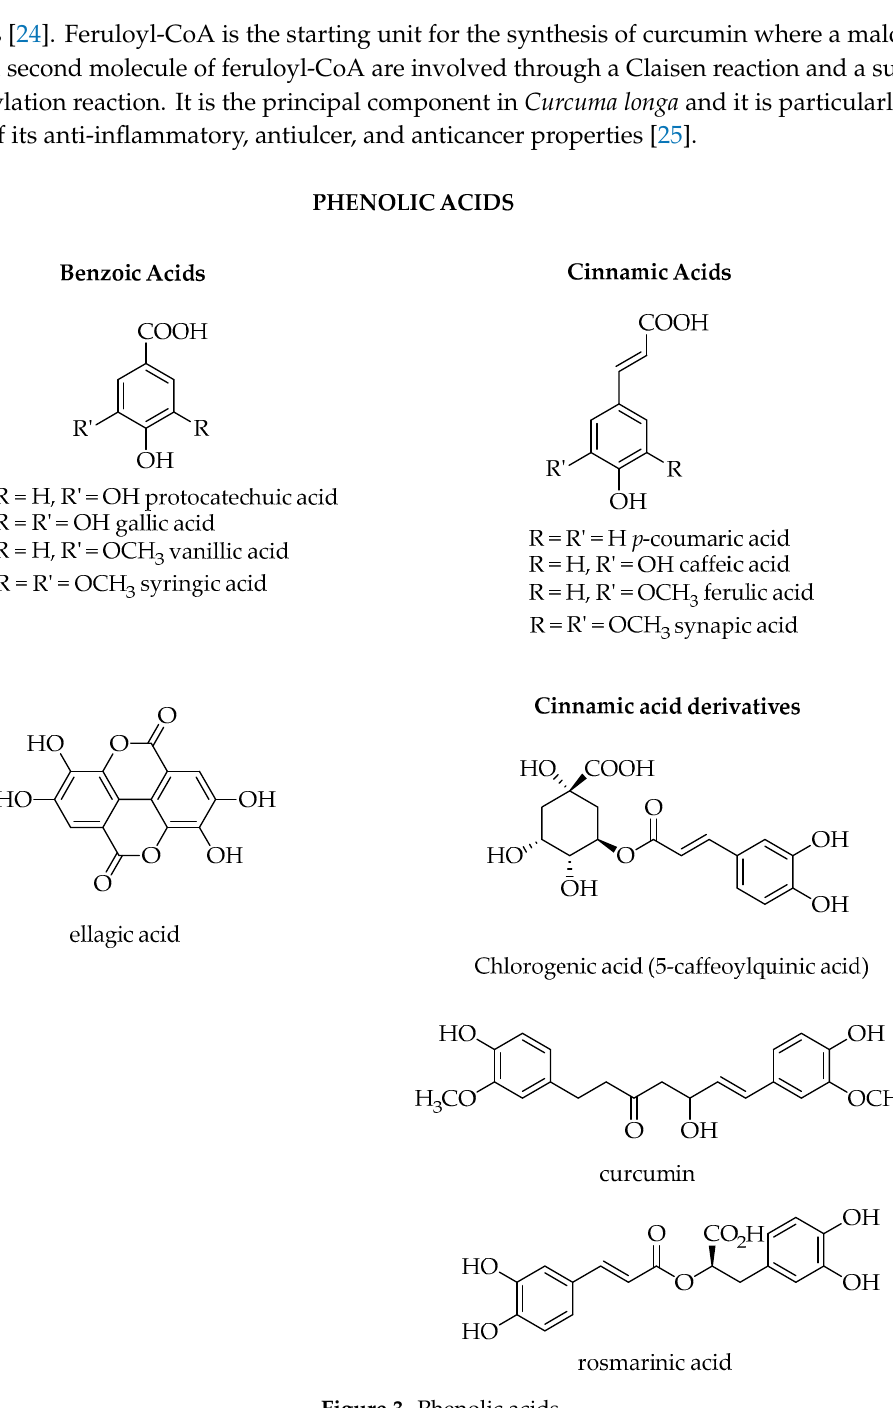
Figure 3. Phenolic acids.